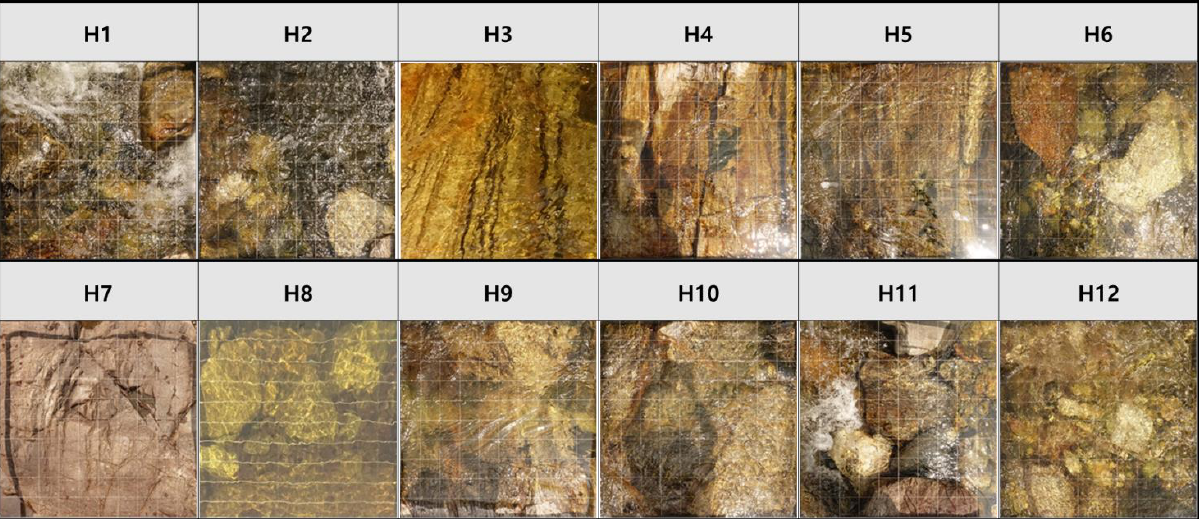
Figure 2. Substrates of the 12 field reaches were placed under-sampling frame 1 by 1 m with a 10 × 10 cm grid.